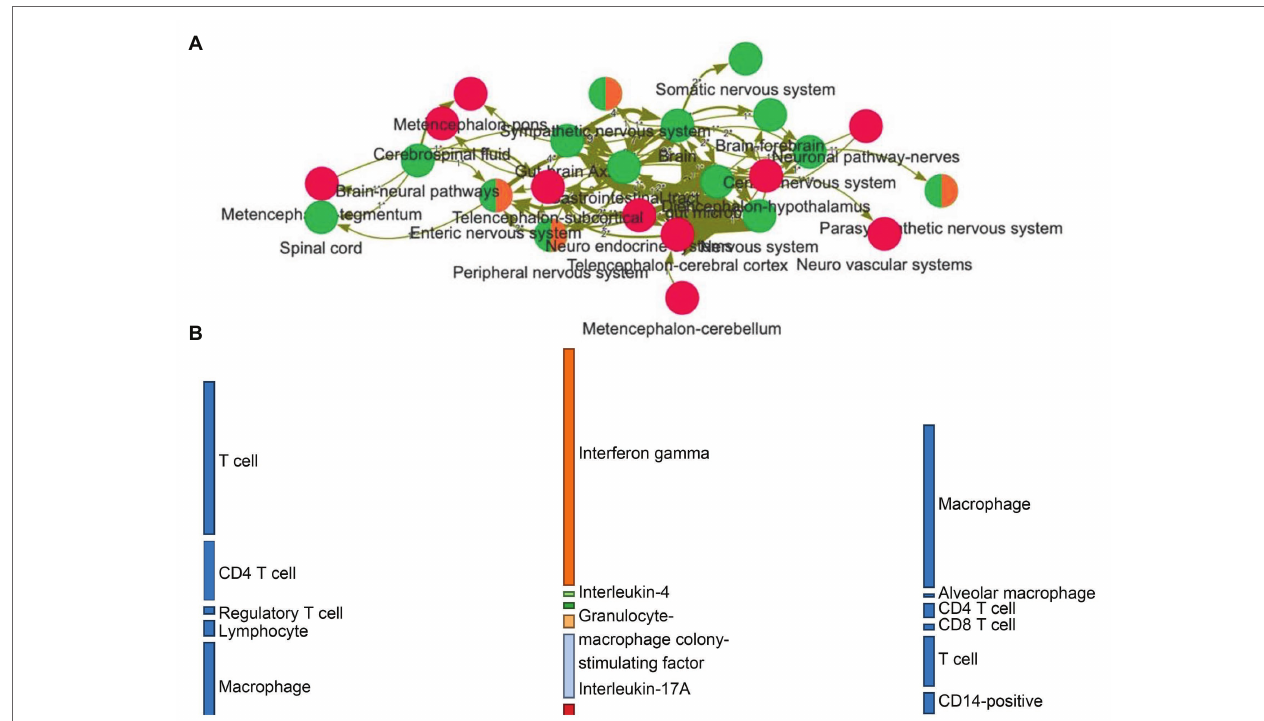
FIGURE 2 | (A) Network visualization of how entities (nodes) relate to each other (edges) based on relations expressed in natural language. The frequency of a relation among entities can be represented with a varying thickness. Red nodes are central nervous system-related entities, green ones represent gut/brain-related annotations, while orange nodes have been classified into the peripheral nervous system. (B) The linguistic relations from the graph can be organized into a flow diagram, allowing the exploration of the directed effects between biological domains. This example makes visible how families of cells are interacting onto cytokines ( leftmost to middle layers) and then how and what cytokines related back to the host cells ( middle to rightmost